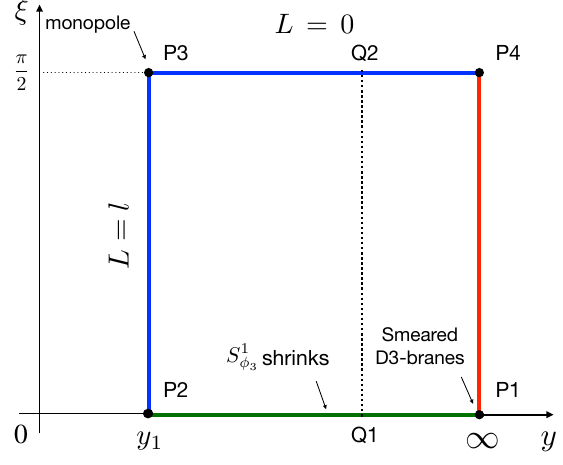
Figure 2 . The two-dimensional base space, B 2 , spanned by y and ξ